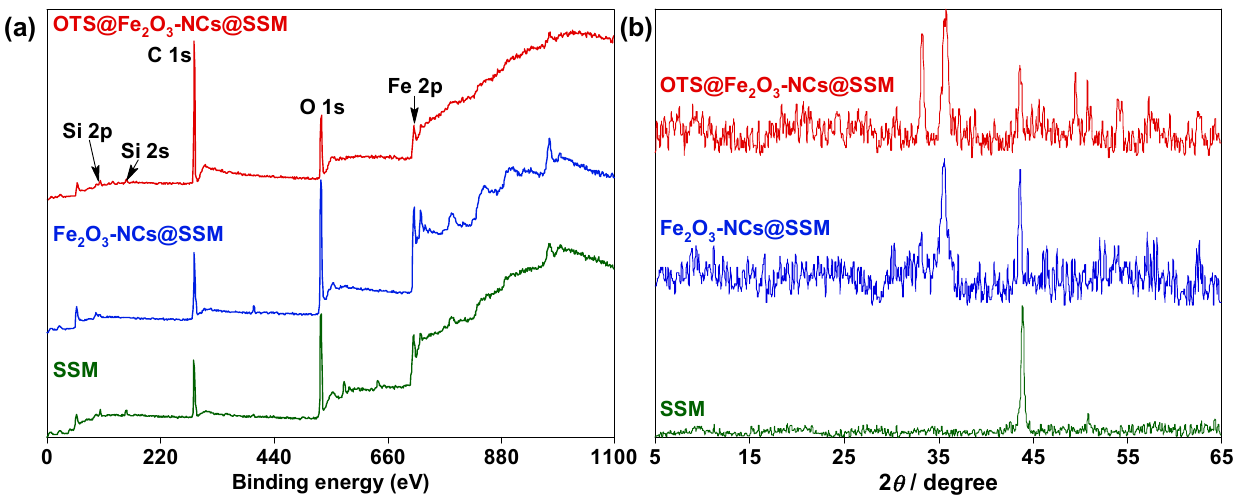
Figure 5. ( a ) XPS analysis of SSM, Fe 2 O 3 -NCs@SSM, and OTS@Fe 2 O 3 -NCs@SSM. ( b ) XRD patterns of SSM, Fe 2 O 3 -NCs@SSM, and OTS@Fe 2 O 3